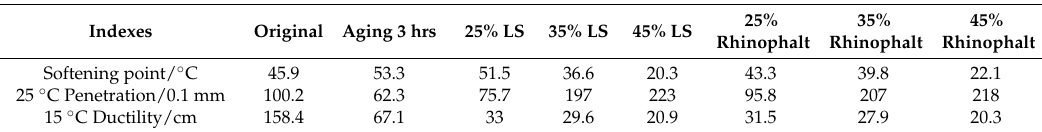
Table 7. The asphalt indexes comparison